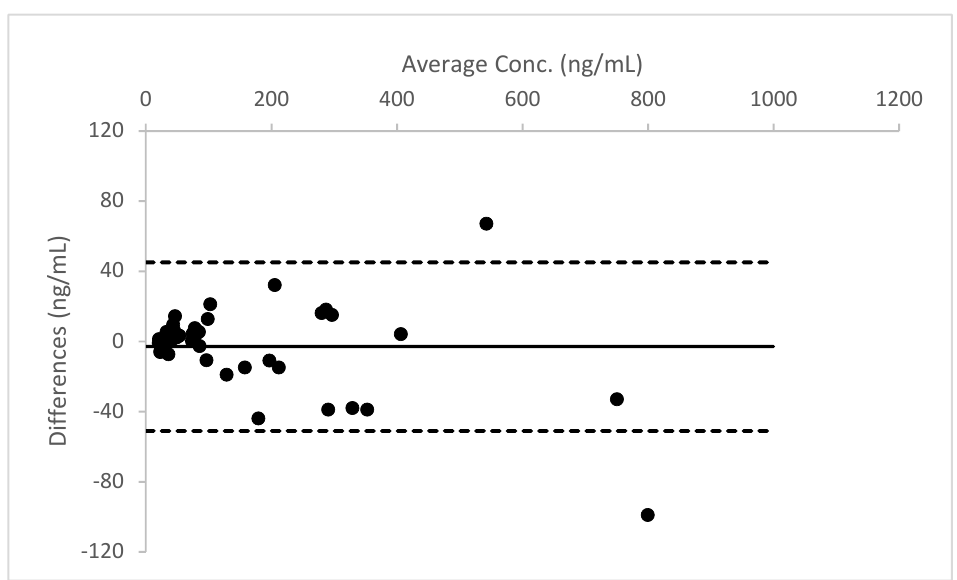
Figure 6. Bland – Altman plot for the results obtained from Whatman™ 903 card, in comparison to the data measured in liquid urine for THCCOOH-gluc.